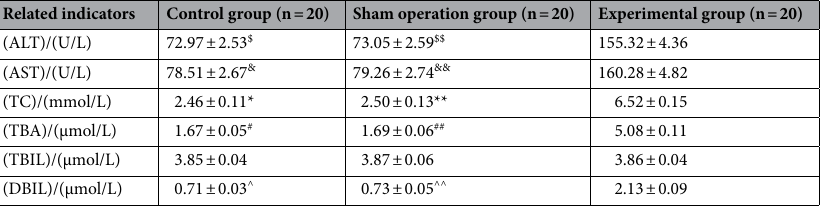
Table 3. Changes of liver function. $ P < 0.05 compared with the experimental group, & P < 0.05 compared with the experimental group, * P < 0.05 compared with the experimental group, # P < 0.05 compared with the experimental group, ^ P < 0.05 compared with the experimental group. $$ P < 0.05 compared with the experimental group, && P < 0.05 compared with the experimental group,** P < 0.05 compared with the experimental group, ## P < 0.05 compared with the experimental group, ^^ P < 0.05 compared with the experimental group. The levels of total cholesterol, total bilirubin, direct bilirubin, alanine aminotransfease and aspartate transaminase, in experimental group were higher compared with the other two groups. ALT: alanine aminotransfease, AST: aspartate transaminase, TC: total cholesterol, TBA: total bile acids, TBIL: Total bilirubin, DBIL: direct